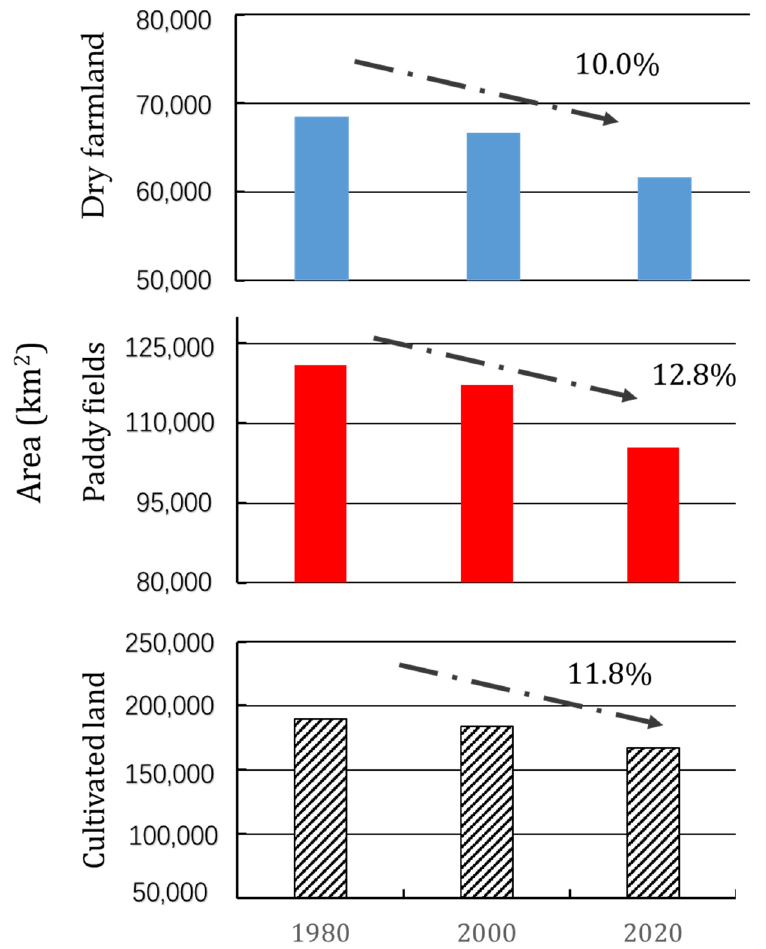
Figure 3. The decreases in the cultivated land area over the past 40 years.